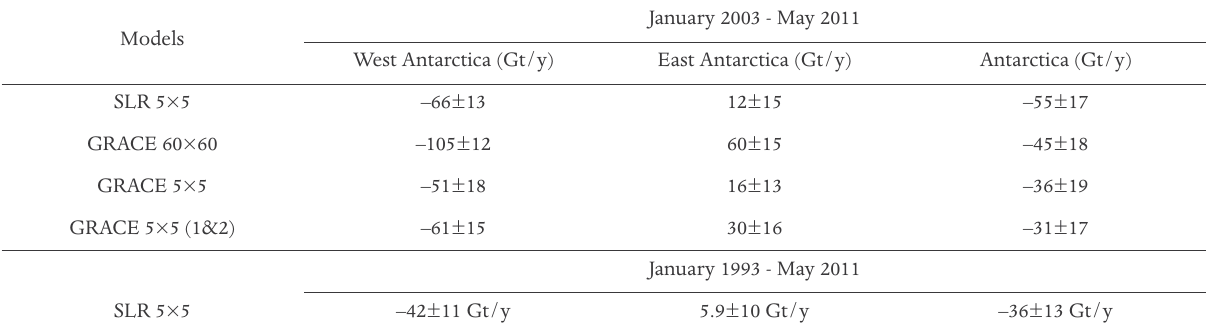
Table 1. The trends of ice mass variations in Antarctica based on four gravity models.